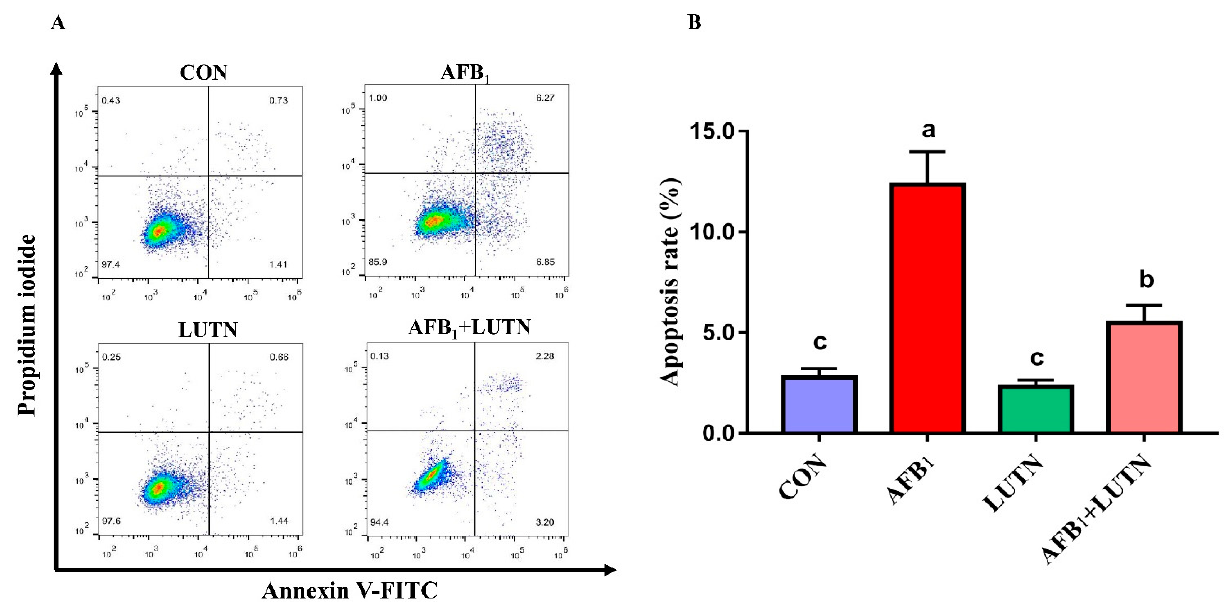
Figure 5. Luteolin treatment prevents AFB 1 -induced apoptosis in mice hepatocytes. ( A ) The apoptosis rates of hepatocytes were measured using flow cytometry. ( B ) Statistical analysis of apoptosis rate. The results are presented as mean ± SD ( n = 3). a–c Columns with different lowercase letters indicated significant differences between the compared groups ( p < 0.05).